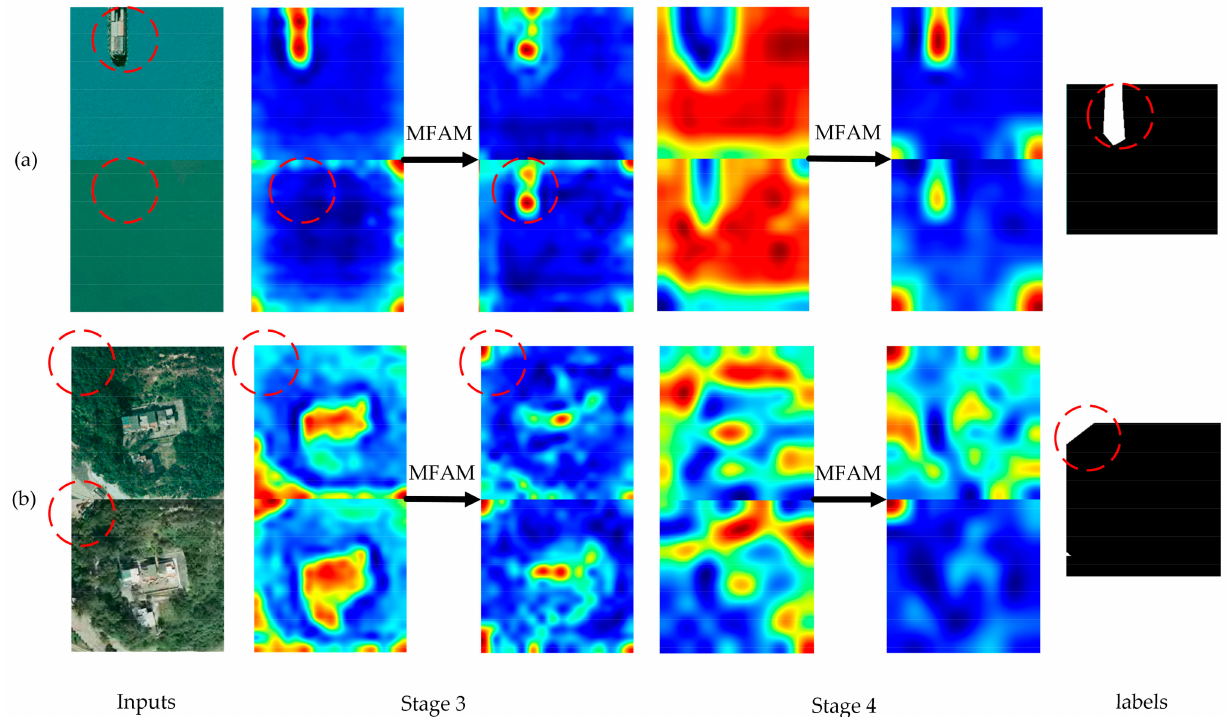
Figure 9. Feature visualization before and after the MFAM module. ( a ) and ( b ) denote the feature visualization of two pairs of images respectively. The red dashed circles show that the use of MFAM causes the encoder to focus on areas where changes may